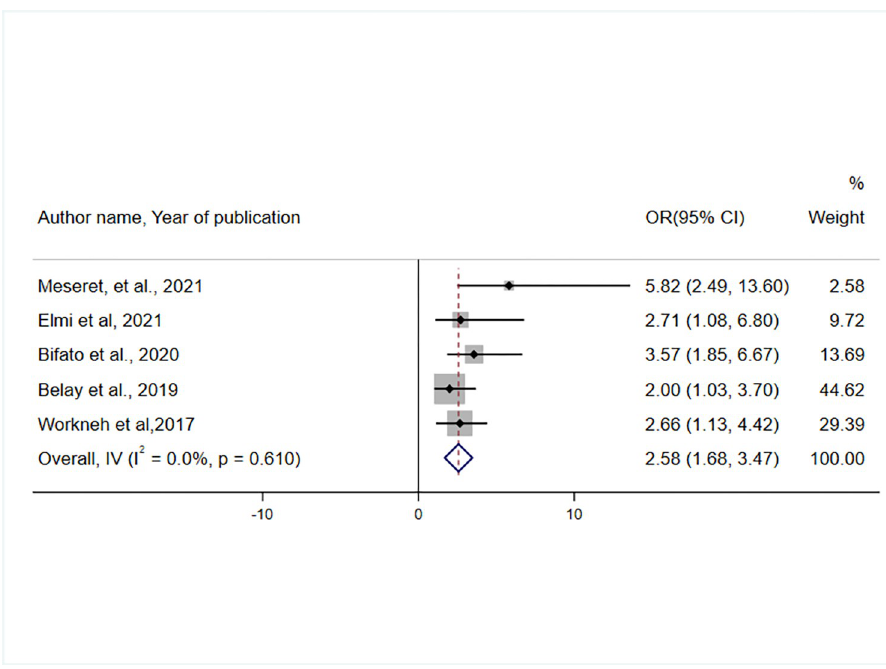
Fig 7. Forest plot showing an association between perceived affordability of premium payment and CBHI enrolment in Ethiopia, 2017–2022.